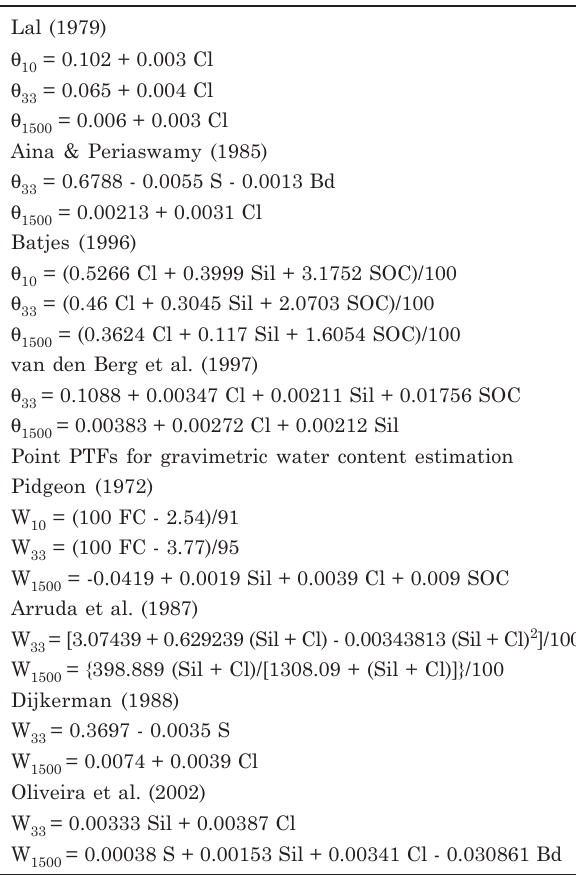
Table 3. Point PTFs selected for estimating water content at specific matric Point PTF for volumetric water content estimation